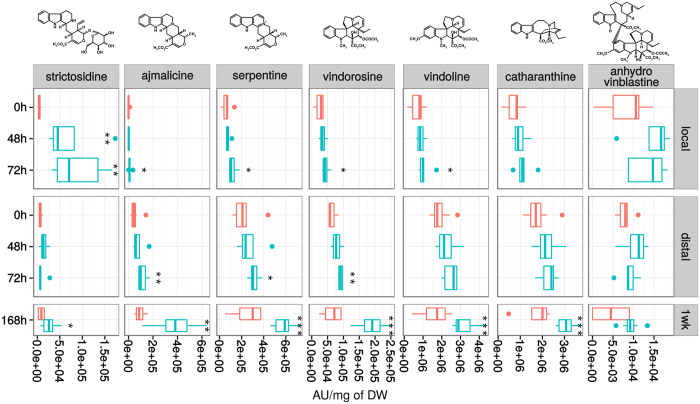
Monoterpene Indole Alkaloid (MIA) accumulation in C. roseus leaves fed by M. sexta.MIA accumulation was monitored 48 h and 72 h after an initial 2 h feeding period, as well as in newly emerged leaves one week after (168 h). Asterisks denote significance levels at *p < 0.05, **p < 0.01 and ***p < 0.001 (non parametric Wilcoxon rank sum test). Red boxes, control (independent, intact plants; see Supplemental Figure S2a); blue boxes, after feeding with M. sexta. AU, arbitrary unit normalized by sample mass.